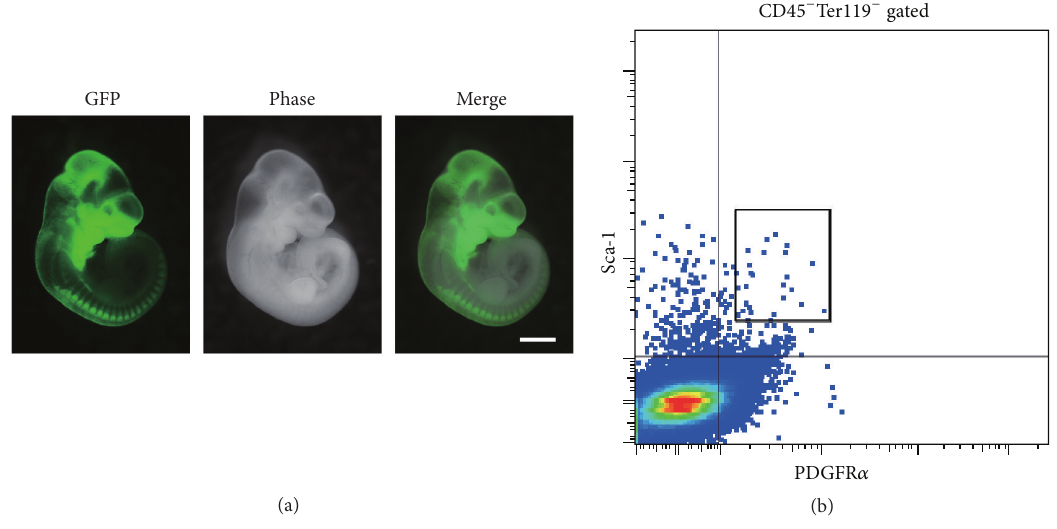
Figure 1: (a) Neural crest lineage labeling mouse (Wnt1-Cre/GFP) clearly demonstrates green fluorescence-positive NCCs in craniofacial tissues at embryonic day 11. Scale bar, 1mm. (b) Murine bone marrow cells were analyzed by flow cytometry. The chart shows that cells expressing hematopoietic lineage markers (CD45 and Ter119) were negatively gated, and the highly potent murine MSC marker-expressing (P 𝛼 S) subset is indicated by the black-colored